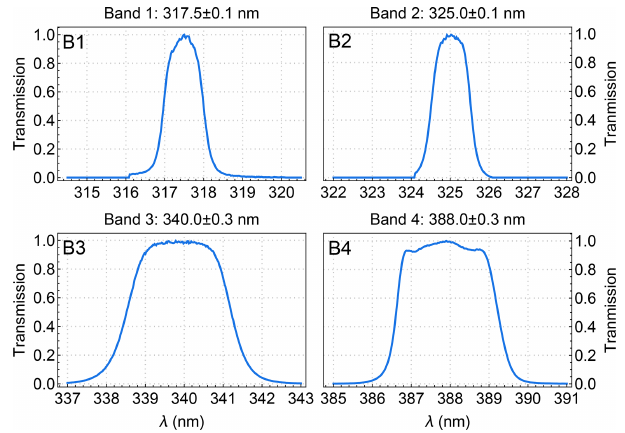
Figure 2. Filter transmission functions for the four EPIC UV chan- nels. The widths are ∼ 1nm for EPIC bands 1 and 2, similar to those for TOMS and OMPS-NM. Note that the filter transmissions as functions of wavelength are measured in the air (see Fig. 1 in Herman et al., 2018). Here we have converted the wavelength in the air to wavelength in a vacuum using the formula of Edlén (1966). The filter values are normalized to 1 at band centers (noted on top of each panel with